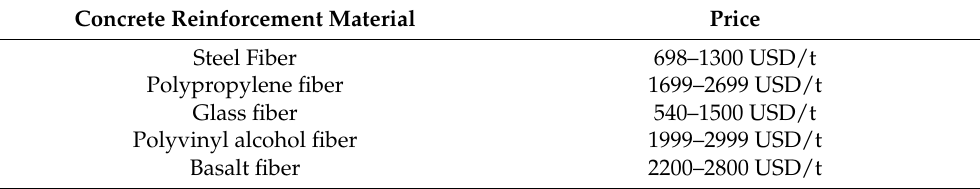
Table 2. Price ranges for concrete reinforcement materials from Alibaba.com